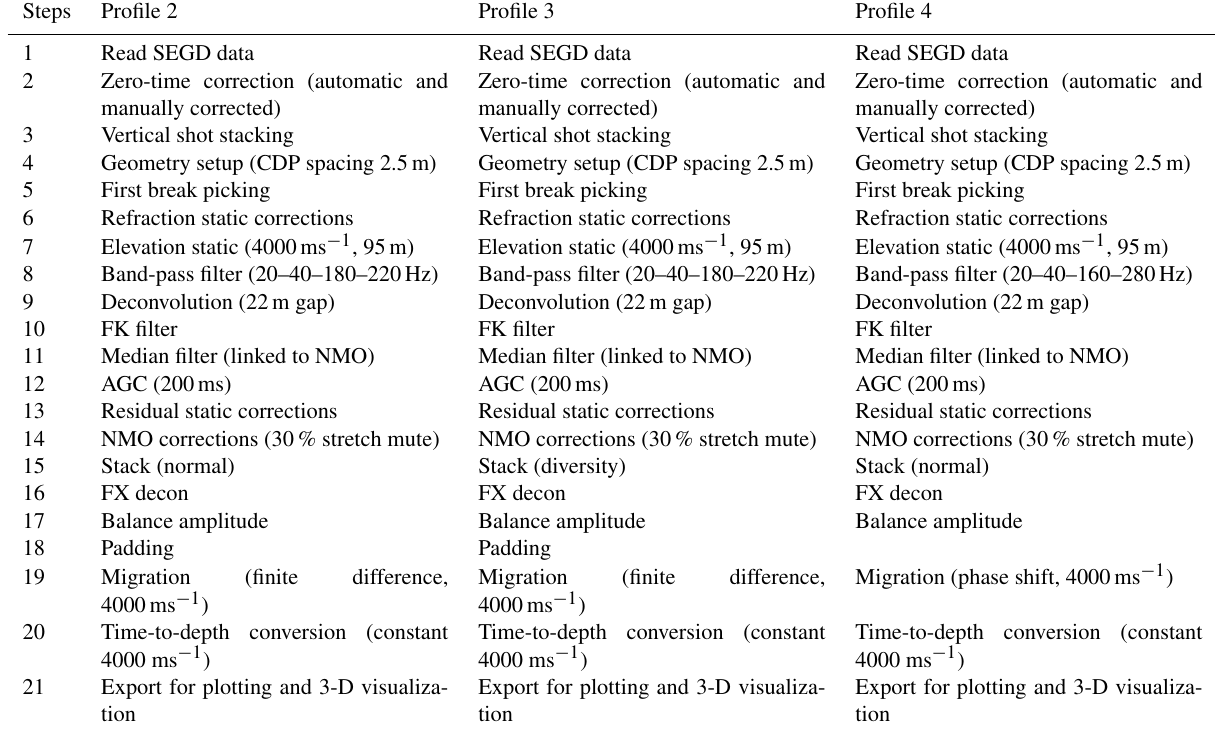
Table 2. Key reflection processing steps (Globe Claritas ™ processing software was used for the processing). Terms in the table are defined as follows: SEGD: Society of Exploration Geophysicists field data, CDP: common depth point, FK: frequency–wavenumber domain, NMO: normal moveout, AGC: automatic gain control, FX: frequency space